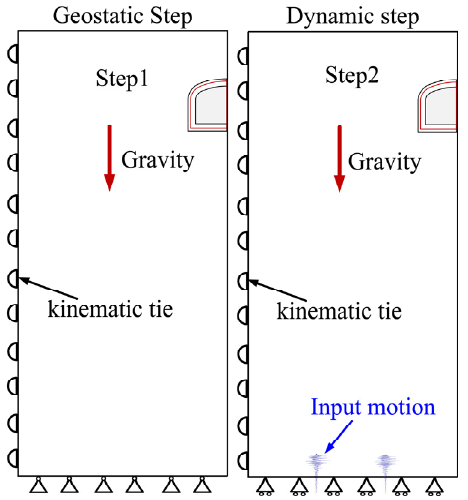
Figure 3. Full dynamic time analysis.